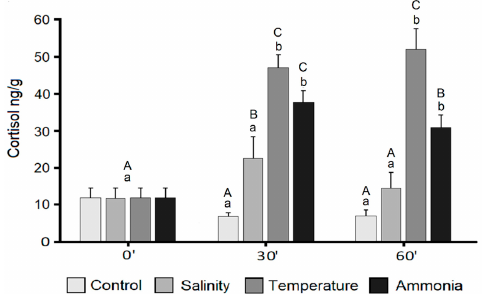
Figure 1. Cortisol concentrations in the different experimental groups of seabream juveniles at each sampling times (0, 30- and 60-min post stress). Data are expressed as mean ± SD ( n = 10). Different letters denote statistically significant differences in time course analysis (lowercase) or within the same sampling point (uppercase) ( p <